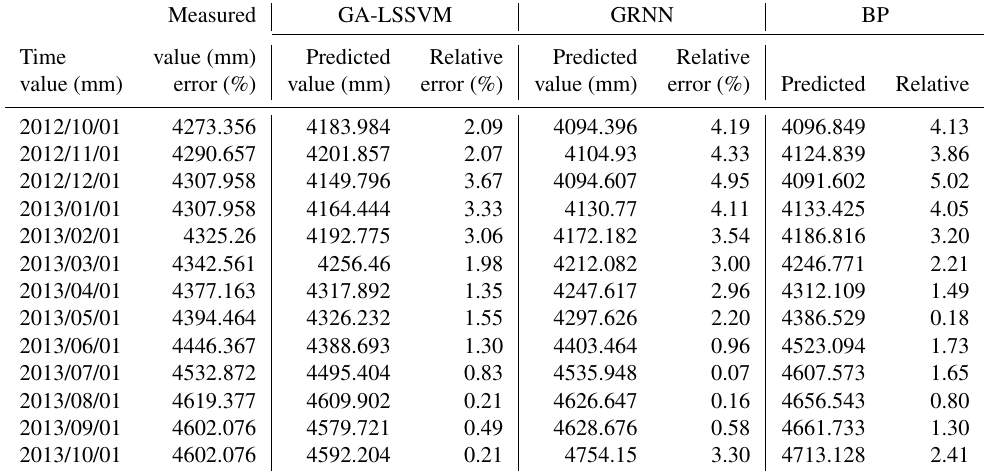
2013/08/01 3719.723 3650.519